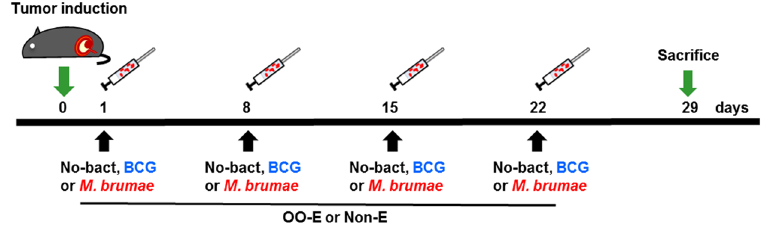
Figure 4. Schedule of the animal experiments. Graphical representation of the schedule, in which tumor induction (day 0), mycobacteria treatments (days 1, 8, 15 and 22 after tumor induction) and sacrifice (day 29 after tumor induction) are indicated by